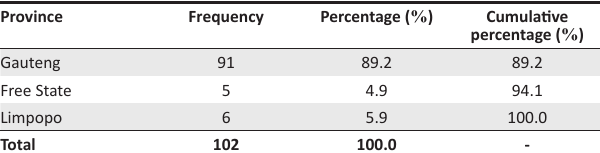
TABLE 1: Place of residence.